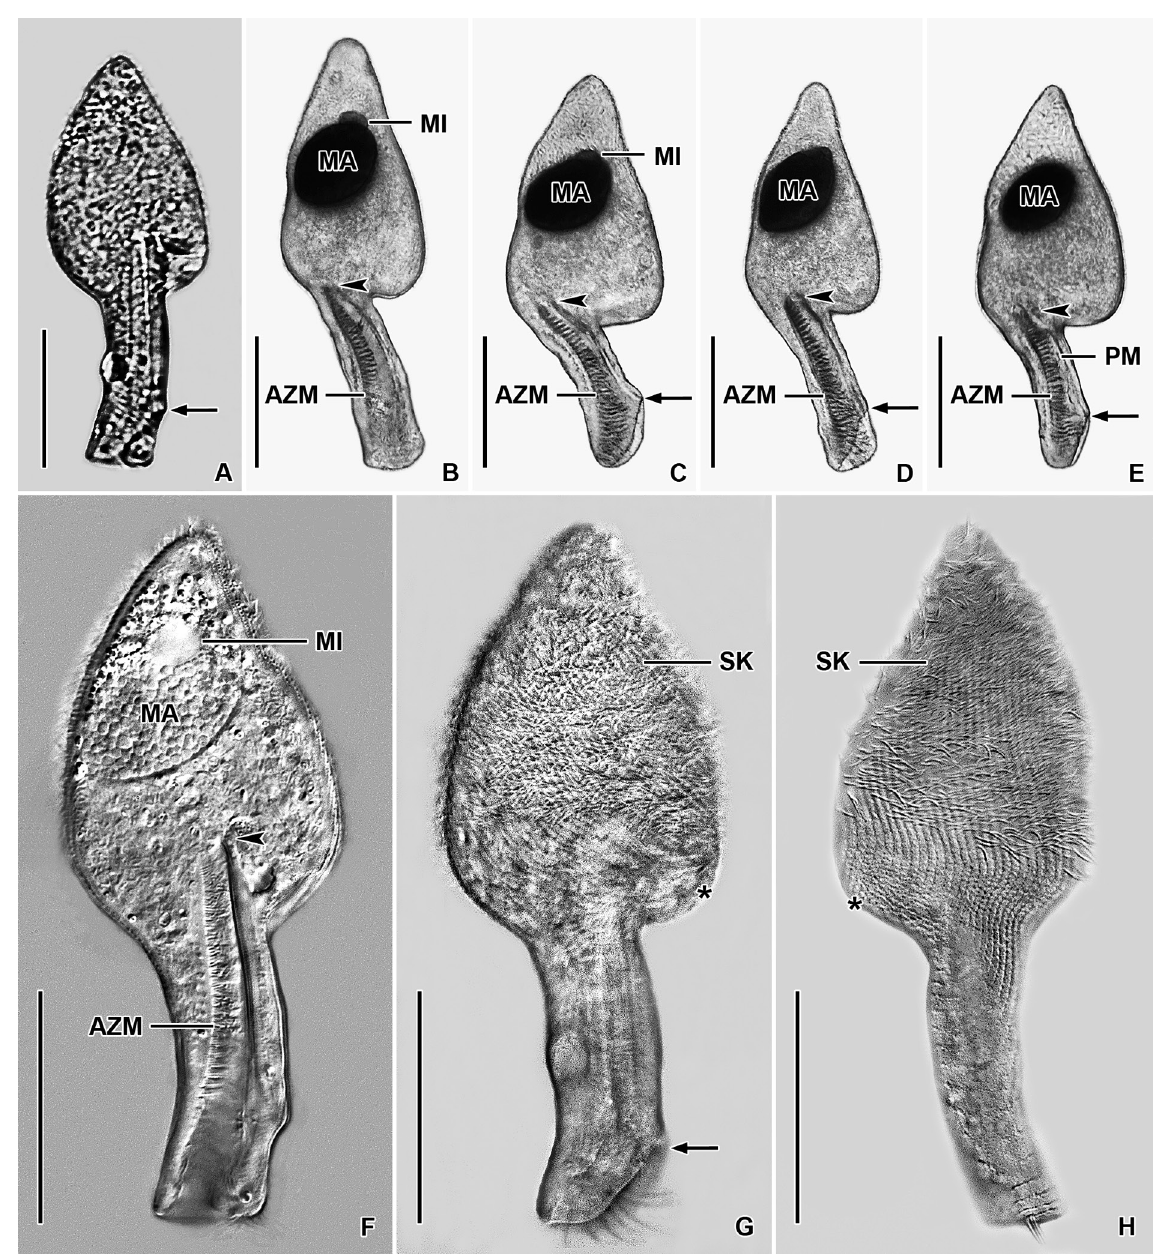
Fig. 5. Clevelandella hastula (Kidder, 1937). Vietnamese specimens isolated from Panesthia angustipennis cognata Bey-Bienko, 1969 from life (A, F–H) and after protargol impregnation (B–E). A–E . Ventral view of specimens with well-preserved body shape. Arrows mark the proximal end of the peristomial opening, black arrowheads mark the proximal end of the adoral zone of membranelles. F . Ventral view, showing general organization of body. G–H . Ciliary pattern of ventral and dorsal sides. Conspicuous cilia of adoral membranelles emerge out of the peristomial opening in (G). asterisks indicate the position of the ciliary whorl (posterior suture), arrow marks the proximal end of the peristomial opening. Scale bars = 30